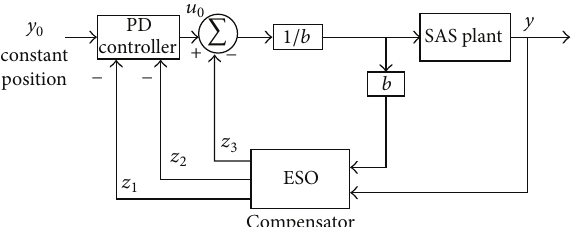
Figure 3: Vibration suppression feedback control of SAS based on ESO.